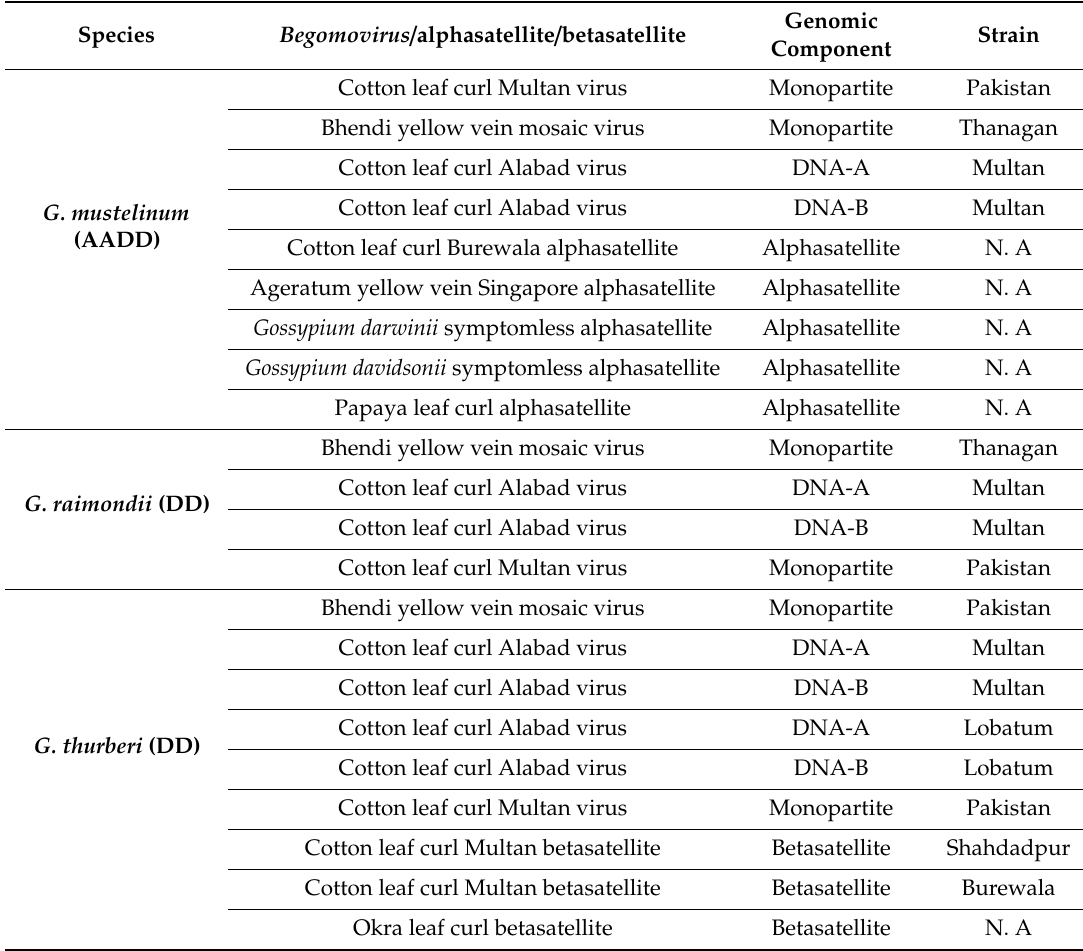
Table 1. Begomovirus , alphasatellite and betasatellite species isolated from G. mustelinum , G. raimondii and G. thurberi